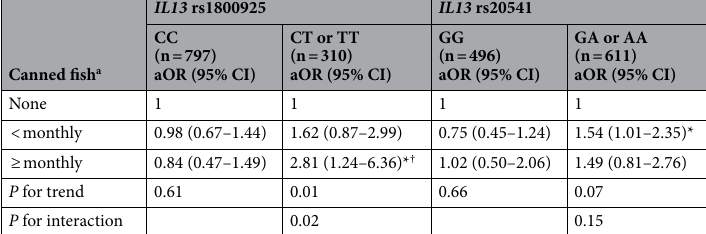
Table 4. The dose–response associations of prenatal canned fish with cord blood total IgE elevation modified by IL13 genetic polymorphisms. aOR, adjusted odds ratio; 95% CI, 95% confidence interval. * P < .05, † P < .05 after FDR correction. a Adjusted for neonatal sex, gestational age, birth body weight, maternal age, parental education, family history of atopic diseases, environmental tobacco smoke, and perception of mildewy